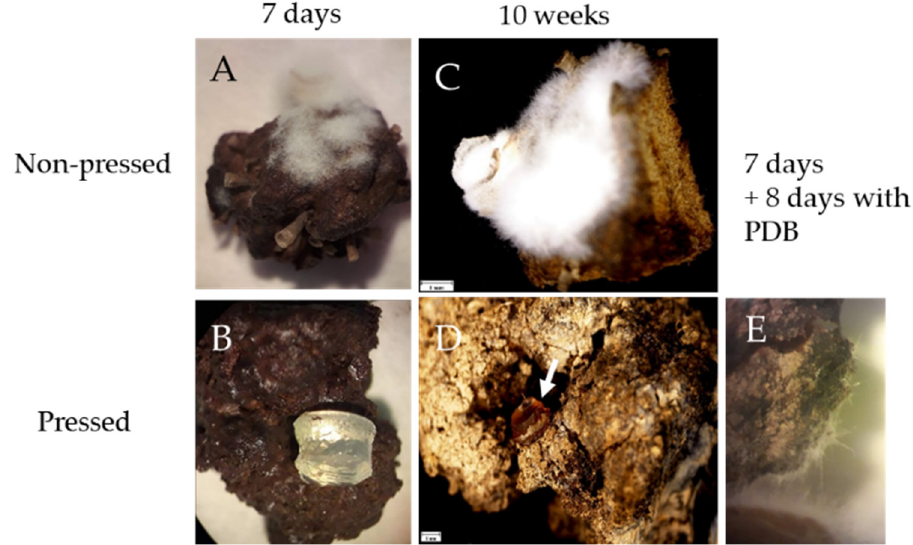
Figure 5. Growth of Parengyodontium album on Agelas oroides . Mycelial plugs of the fungus on non-pressed ( A ) and pressed ( B ) fragments of A. oroides , seven days post inoculation and 10 weeks post inoculation ( C , D) (Plug is marked with arrow). Growth of the P. album on a pressed fragment of A. oroides 15 days post inoculation ( E ). Seven days after inoculation, potato dextrose broth (PDB) was added to the edge of the sponge.